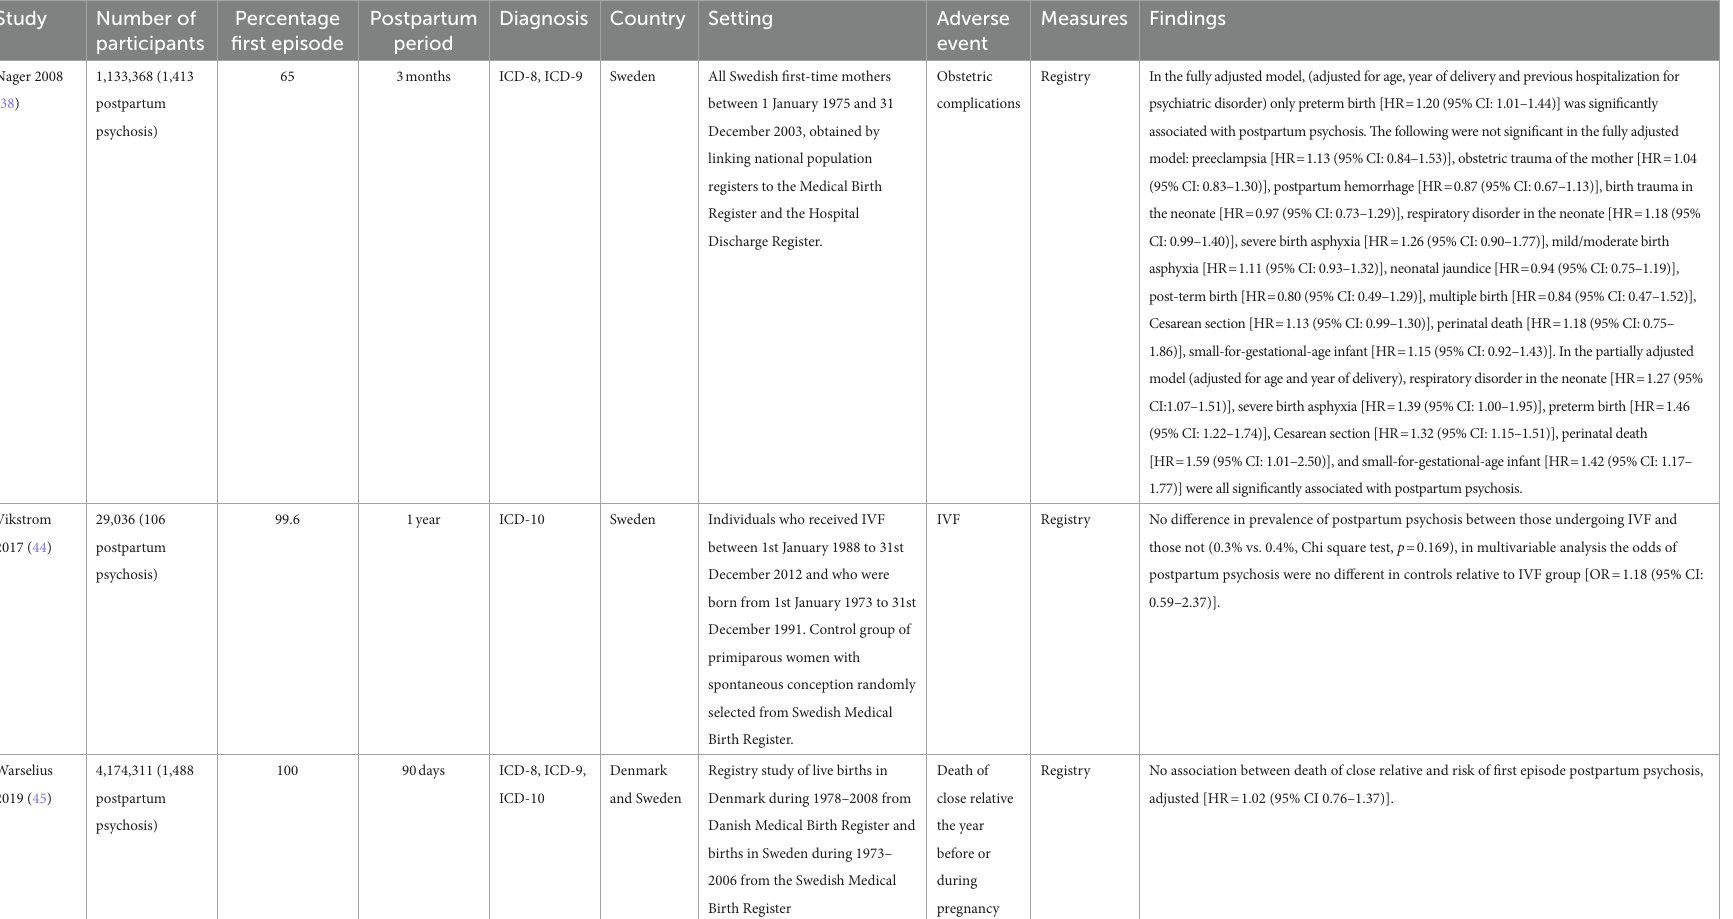
Registry No association between death of close relative and risk of first episode postpartum psychosis, adjusted [HR = 1.02 (95% CI